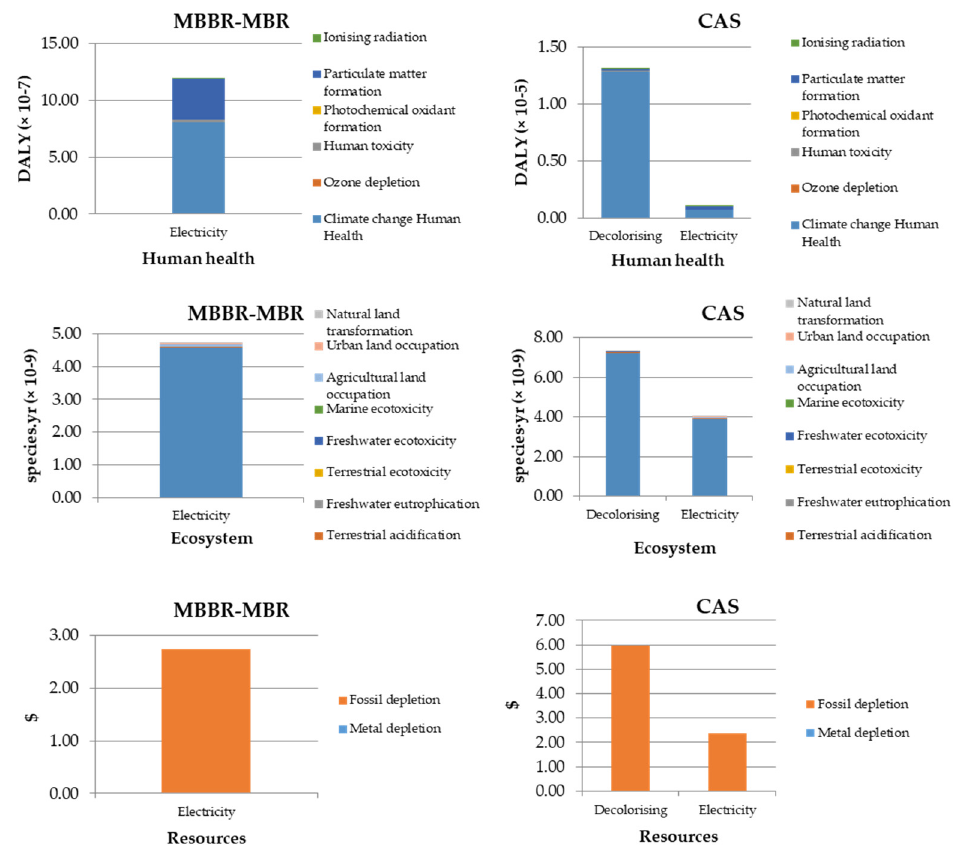
Figure 2. Comparative analysis of the effect of electricity and decolorizing agent consumption on the impacted categories of MBBR-MBR and CAS. impacted categories of MBBR-MBR and